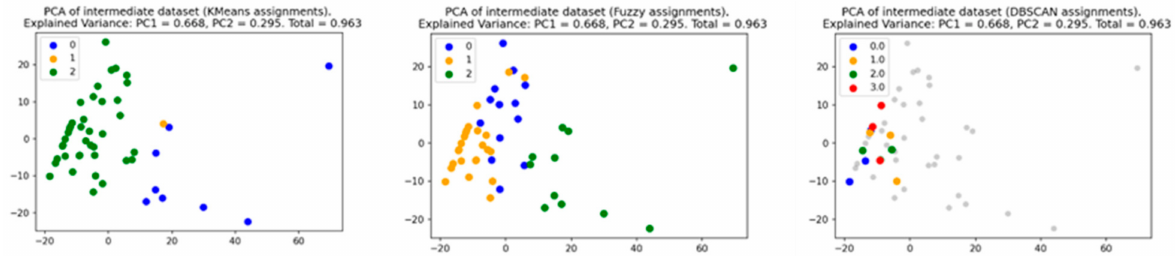
Figure 6. Cluster analysis in the intermediate measurement (four weeks after the beginning of the semester) with the k -means ++, fuzzy k -means, DBSCAN algorithms.